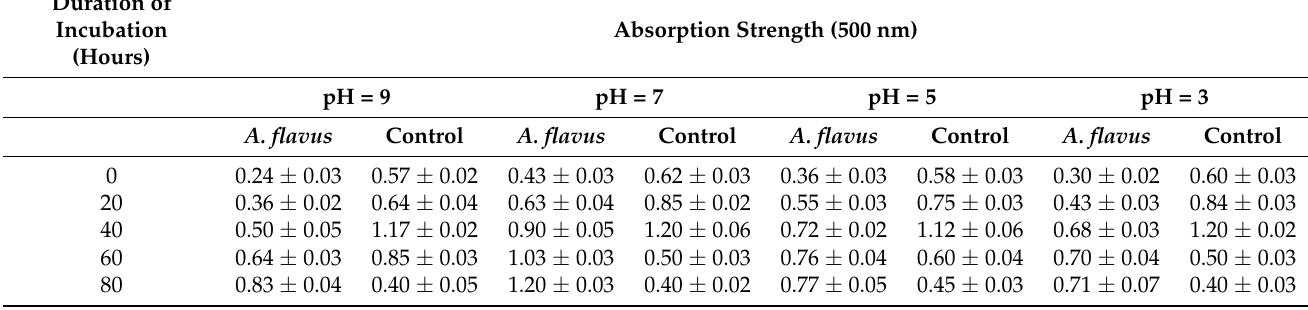
Table 2. Effect of pH on the absorption of fermented rice (koji) extract by A. flavus in different incubation periods at 40 ◦ C. Duration of Incubation